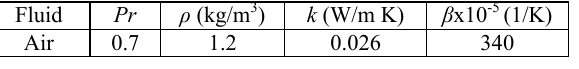
Table 2. Environmental chamber